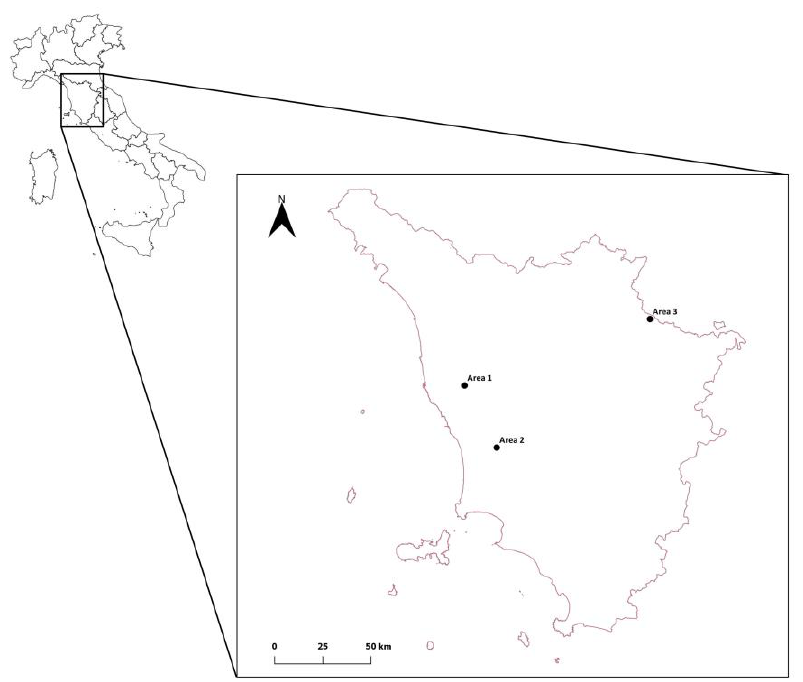
Figure 1. Map of the location of the Tuscany Region. In detail, the location of the anthropized site in Pisa Province (Area 1), the Monterufoli Caselli Nature Reserve (Area 2), and the Foreste Casentinesi National Park (Area 3) (black dots), where sampling was performed.